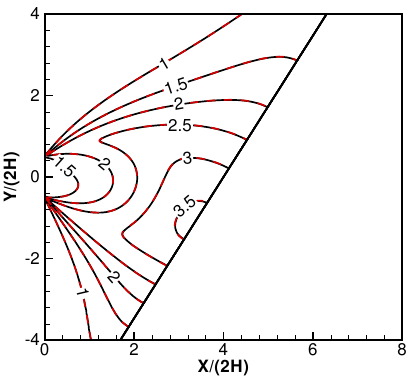
Figure 6. Temperature contours for free jet impingement on an inclined, flat, planar, specular reflective plate. Solid: analytical; dashed: DSMC.